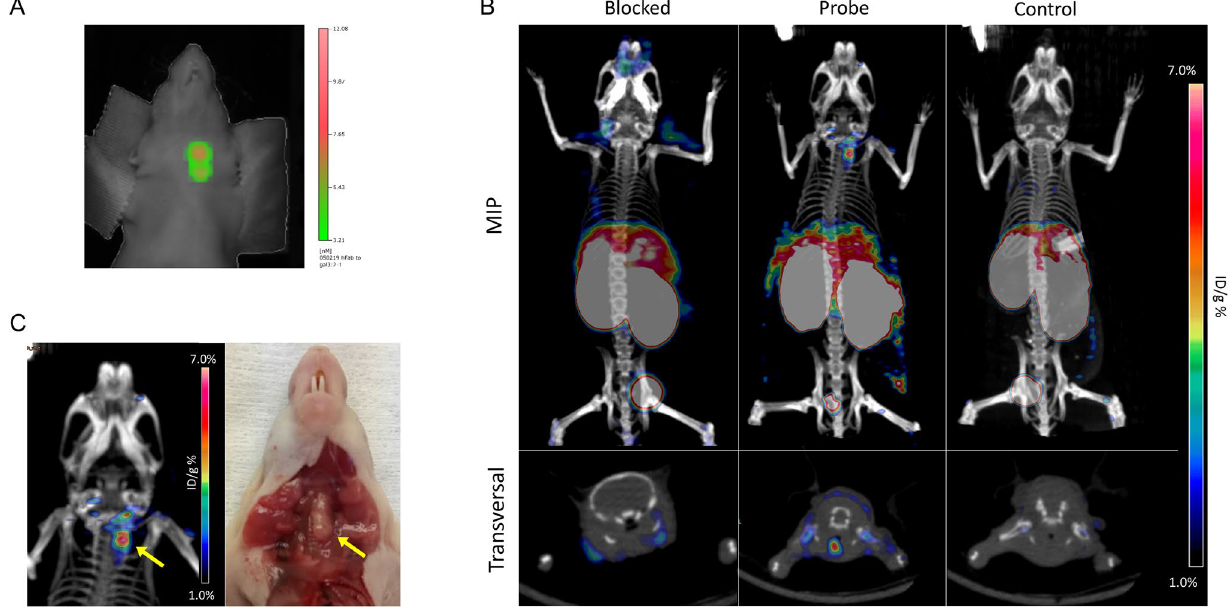
Figure 7. Imaging of thyroid orthotopic tumors growing in a xenograft mouse model using fluorescence- labeled and radiolabeled GaletuzuFab-PAS200. ( A ) Representative FMT imaging of a mouse bearing a FRO82-1 xenograft tumor. The scan performed 24 h after the injection of 130 µg GaletuzuFab-PAS200-Cy7 shows a hGal3-positive lesion in the neck. ( B ) PET/CT images acquired 24 h after intravenous injection of GaletuzuFab- PAS200-Dfo- 89 Zr (3 MBq) in animals from different groups: (1) co-injected with a 1000-fold excess of non- radioactive GaletuzuFab-PAS200-Cys to confirm the specificity of tracer binding in vivo (blocking experiment, left); (2) injected with the radioactive probe only (center); (3) healthy animals (without tumor) injected with the radioactive probe (control, right). The lower transversal images taken at the level of the neck area reveal the position of the tumor on the left side of the trachea while the upper images show maximum imaging projection (MIP) whole-body PET images. ( C ) Representative PET image of the neck area of an animal from the center group; the position of the PET signal corresponds to the findings at necropsy. Graphics were prepared using TrueQuant Imaging Software version 2.0 (https:// www. perki nelmer. com) for the fluorescence scans and Inveon Research Workplace version 4.0 (https:// inveon- resea rch- workp lace. softw are. infor mer. com) for the PET/CT image